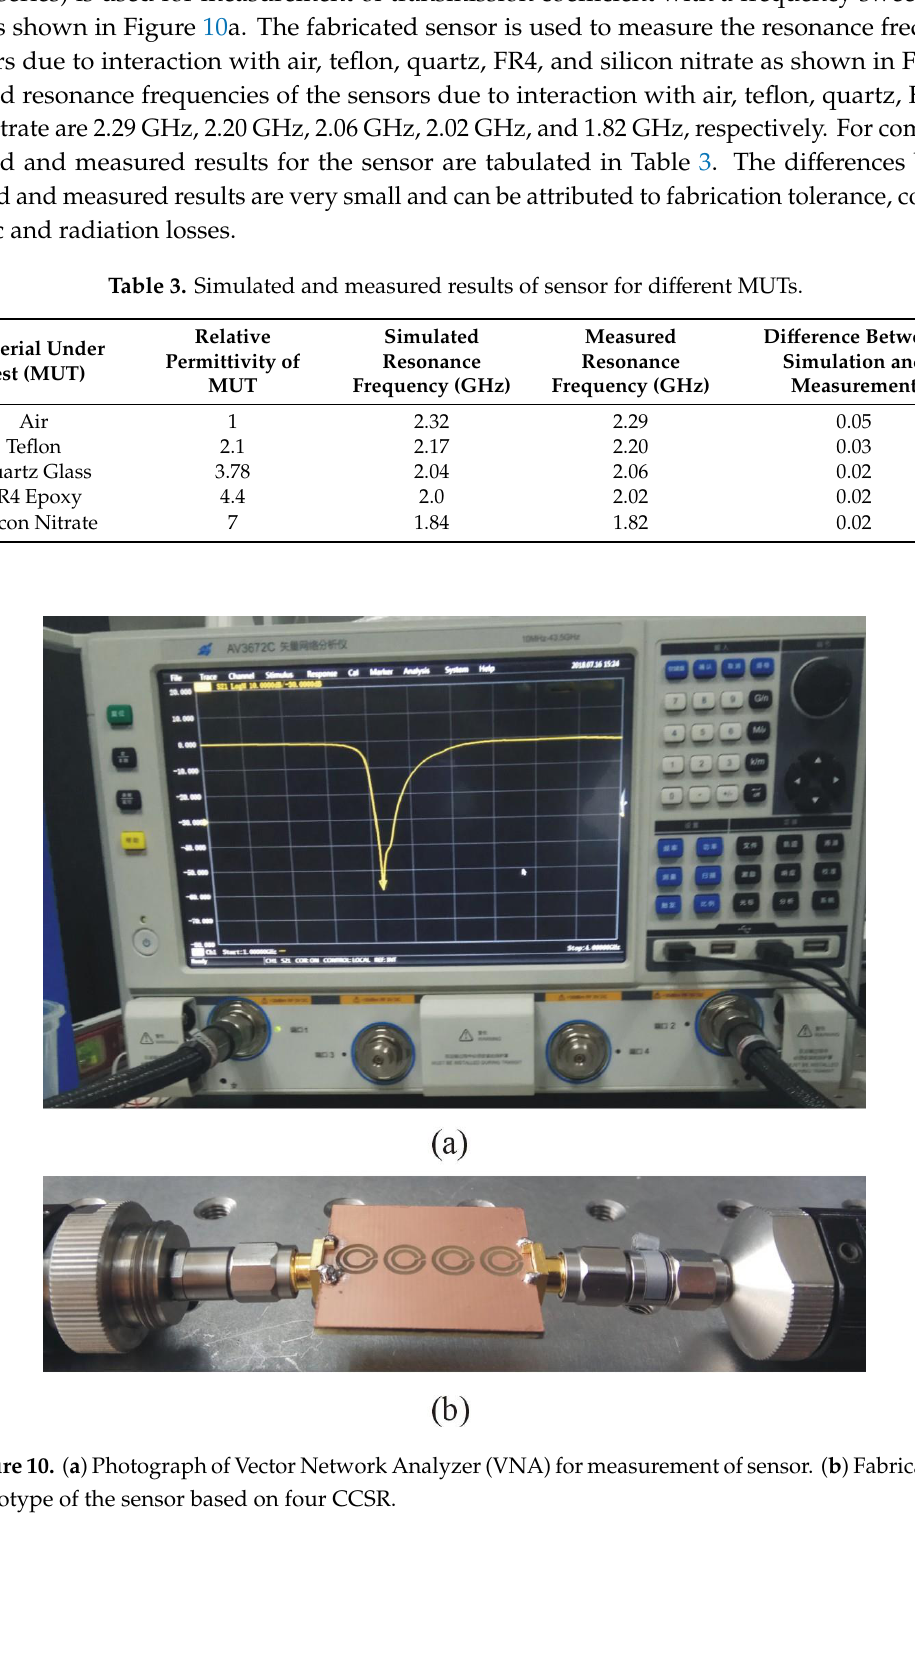
Figure 9. Simulated transmission coefficient S 21 (dB) of sensor due to interaction with different MUTs. Resonance frequencies of sensors due to interaction with air, teflon, quartz, FR4, and silicon nitrate are 2.32 GHz, 2.17 GHz, 2.04 GHz, 2.0 GHz, and 1.84 GHz, respectively.